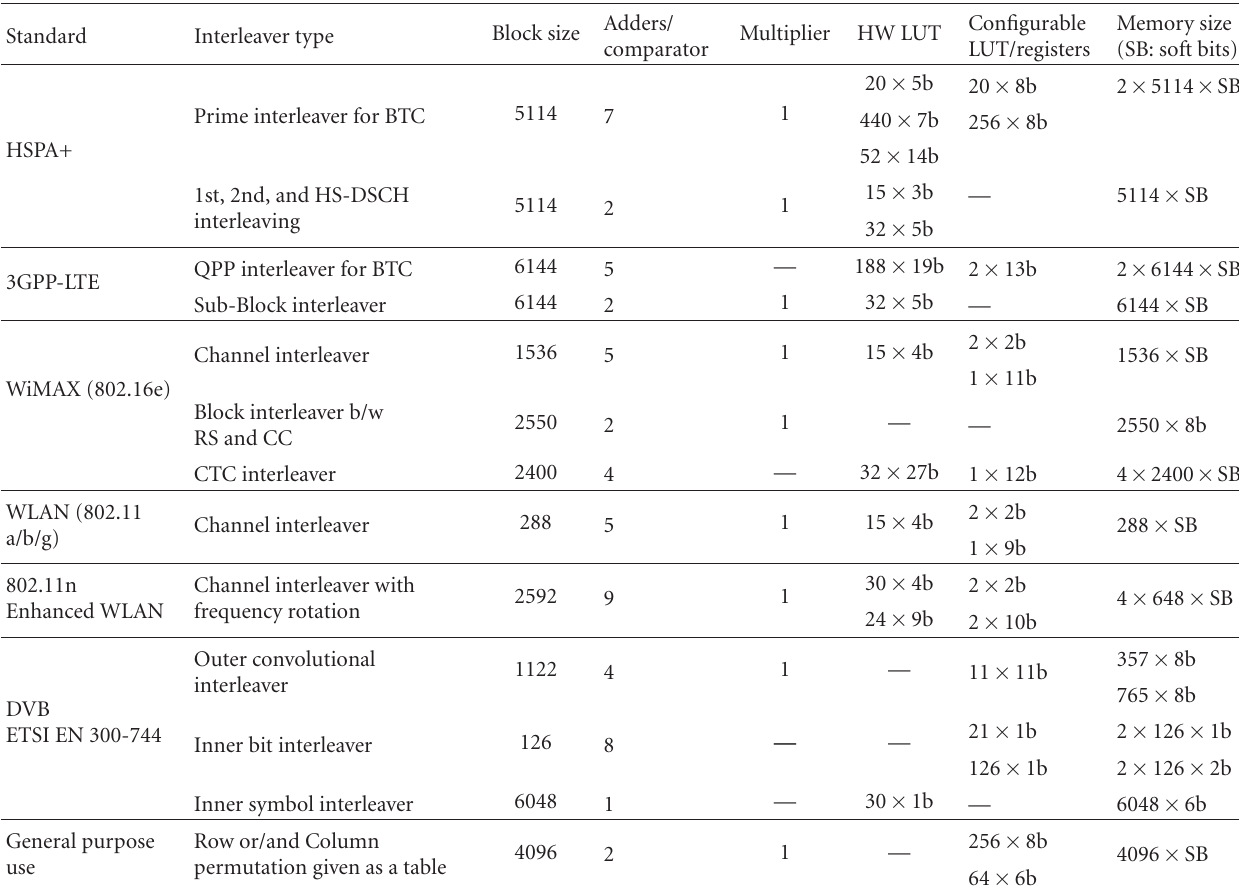
Table 2: Architecture exploration for di ff erent